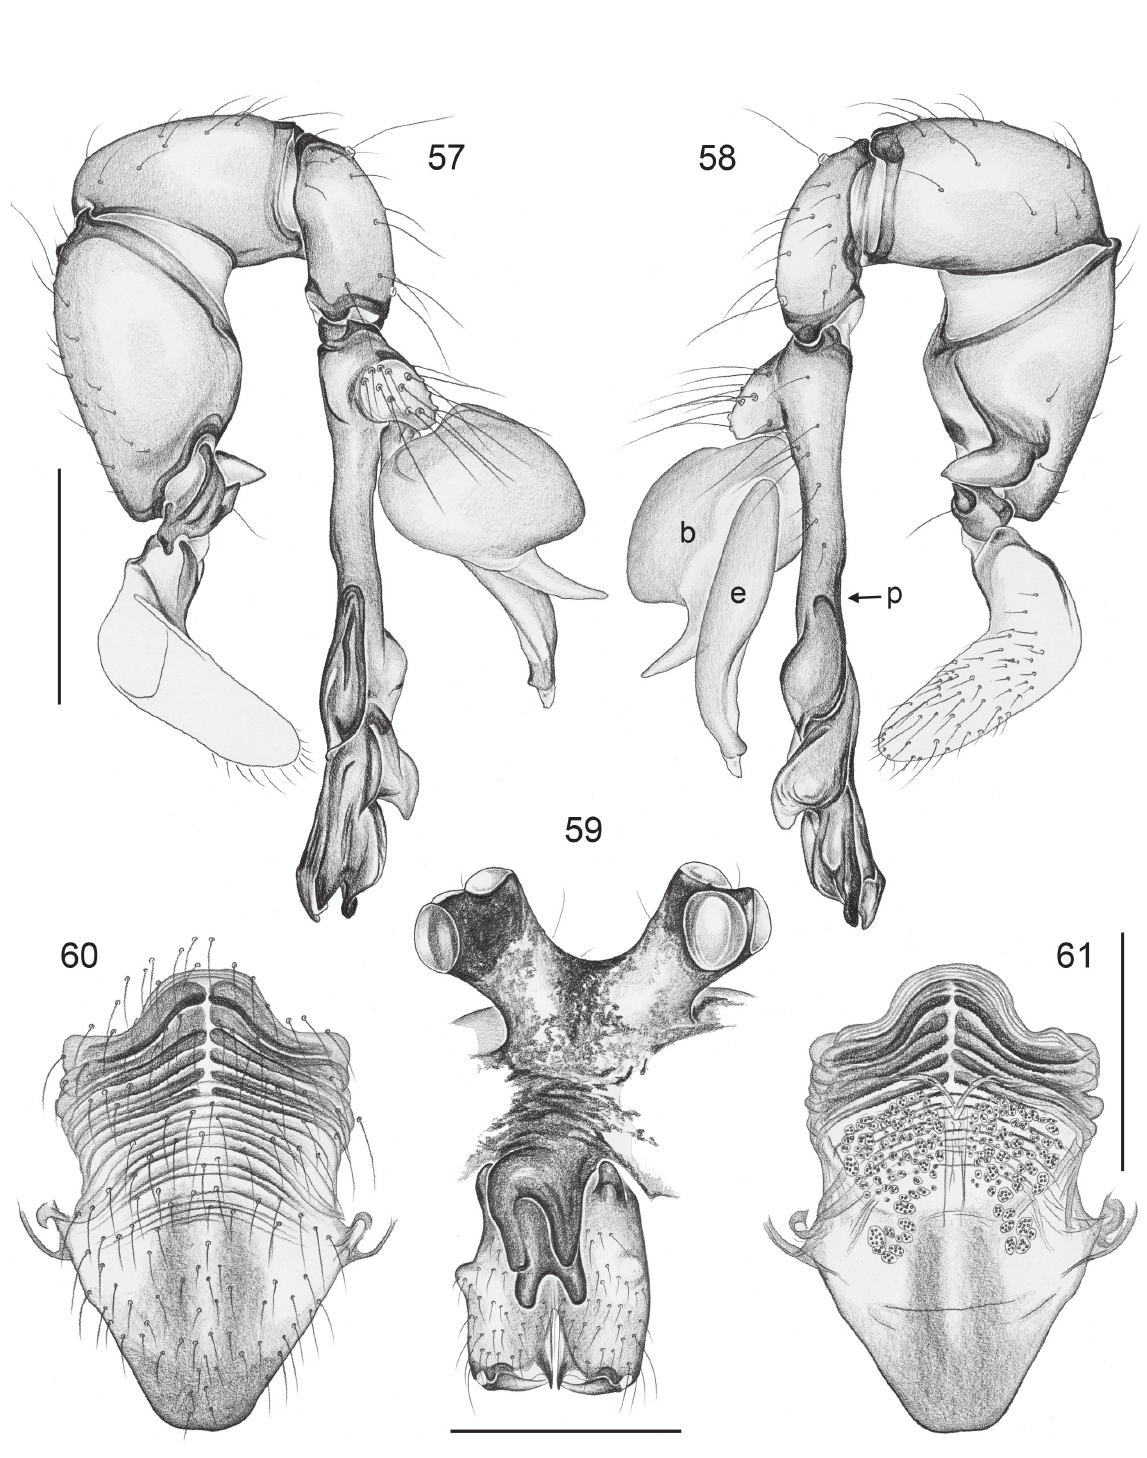
Figs 57–61. Aetana kiukoki Huber, sp. nov. 57–58 . Left male palp, prolateral and retrolateral views. 59 . Male prosoma, oblique frontal view. 60–61 . Cleared female genitalia, ventral and dorsal views. b = genital bulb; e = embolus; p = procursus. Scale lines: